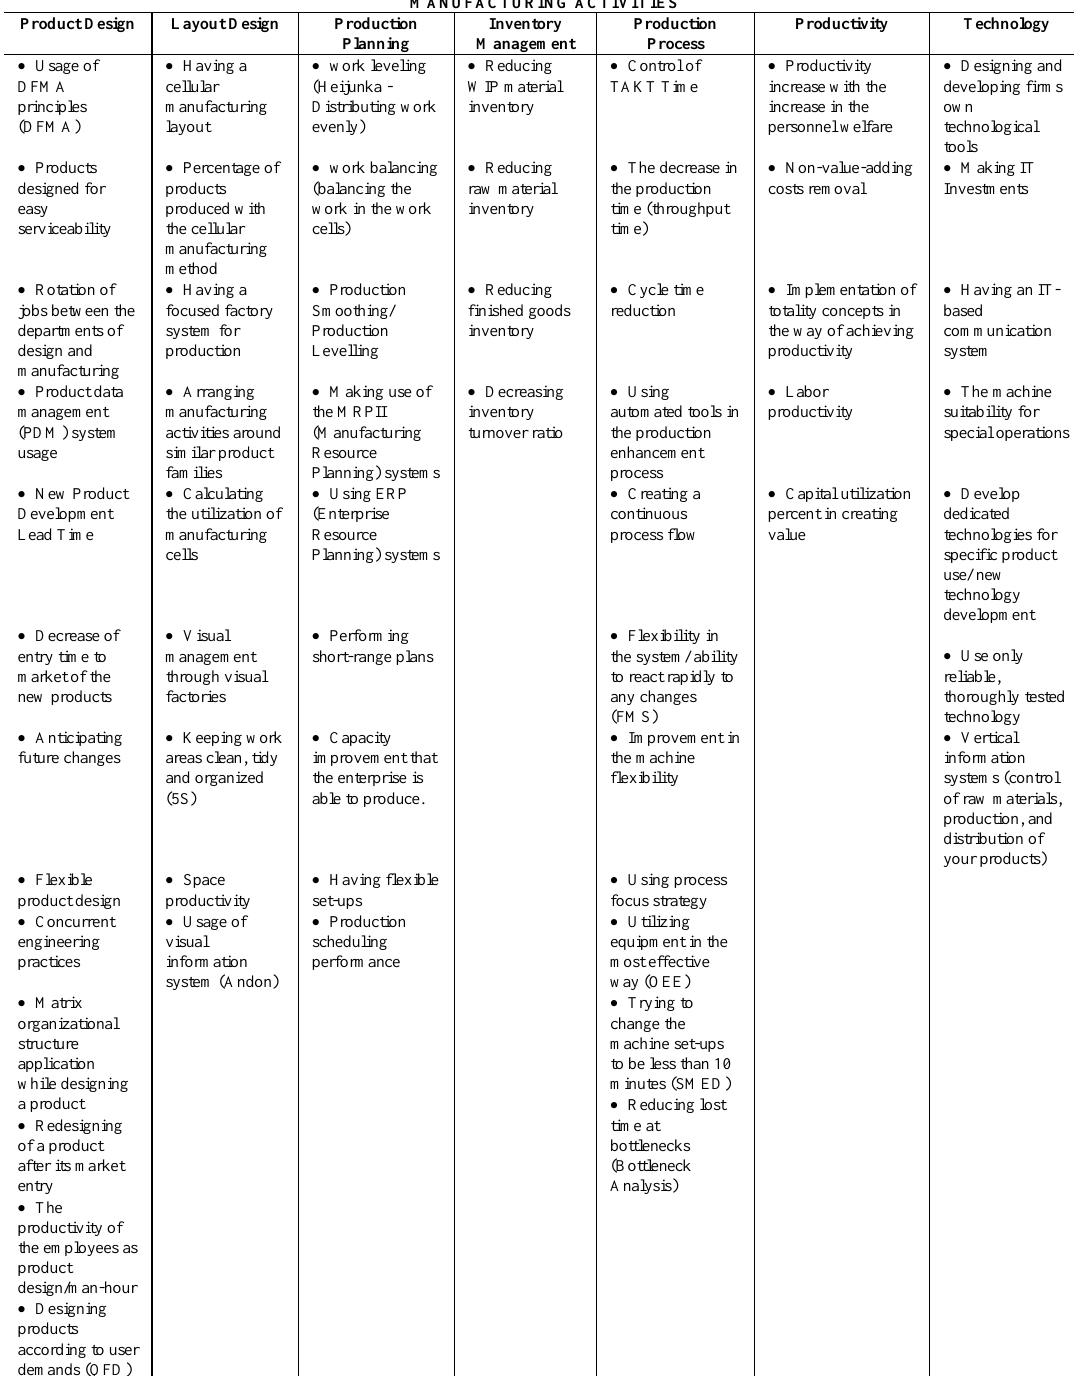
Table 4. Sub-criteria and measures for the manufacturing activities main